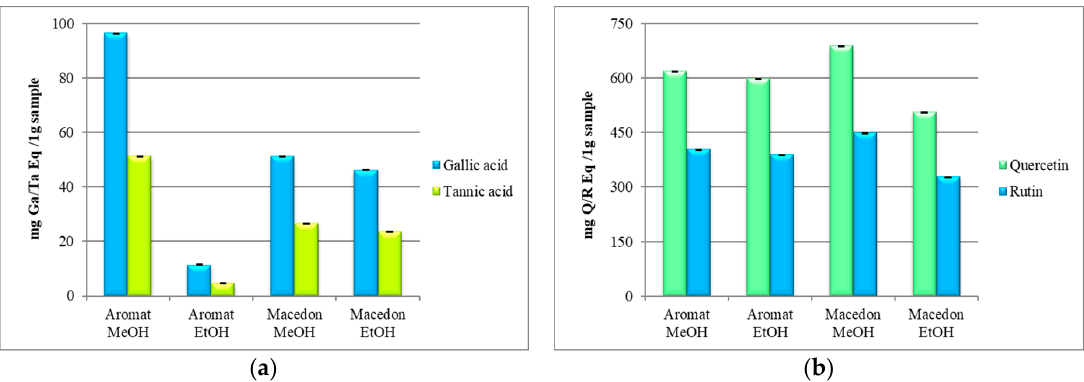
Figure 2. The total content of the phenolic acids ( a ) and flavonoids ( b ) extracted from “Aromat de Buzau” ( O. basilicum ) and “Macedon” ( O. citriodorum ) extracts. The results were expressed in equivalents of gallic acid and tannic acid per 1 g sample, and quercetin and rutin per 1 g sample,